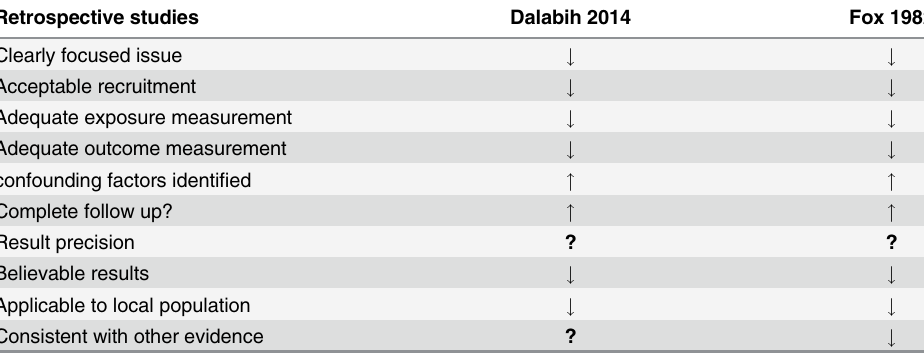
Table 2. Assessment of quality in observational